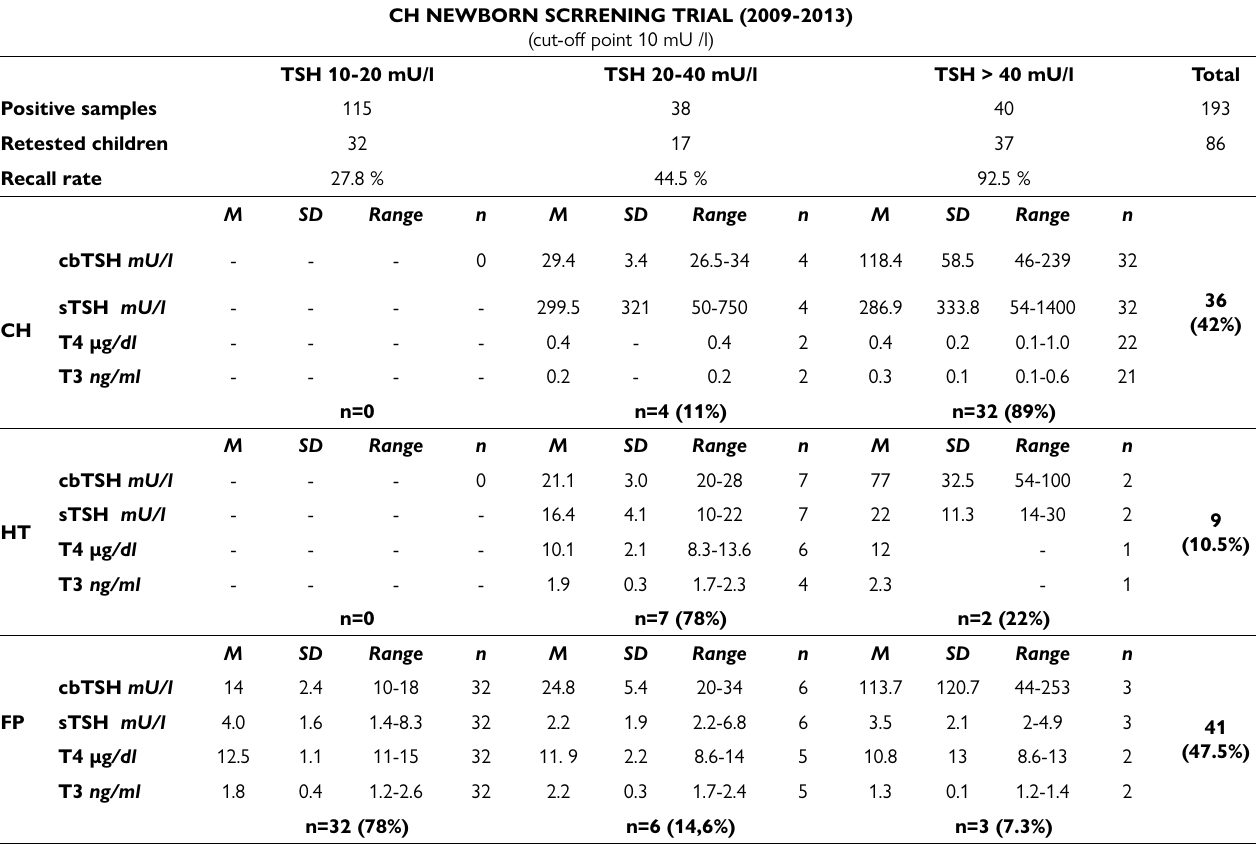
Table 3. Thyroid hormone profile of positive children at the Nicaraguan CH screening trial (2009-2013) categorized in 3 groups depending on cord blood TSH levels: 10-20, 20-40 and >40 mU/l, respectively. CH, congenital hypothyroidism; HT, hyperthyrotropinemia; FP, false positives. cbTSH, TSH from cord blood (eluate from filter-paper spots); sTSH: serum TSH at recall; T4, serum total thyroxine at recall; T3, serum total tri-iodothyronine at recall. M, mean; SD, standard deviation; n, number of individuals. For reference ranges of serum TSH, T4 and T3 (see references 26-29). Reference ranges for sTSH: < 10 mU/l (Hubner et al 2002; Djemli et al., 2004; Kapelari et al., 2008, Rastogi & LaFranchi 2010), and <7 mU/l between 1-12 months of life (Hubner et al 2002; Djemli et al., 2004; Kapelari et al., 2008) for T4: 6.9-16 µg /dl (Rastogi & LaFranchi , 2010) and for T3: 0.9-2.4 ng/ml (Djemli et al